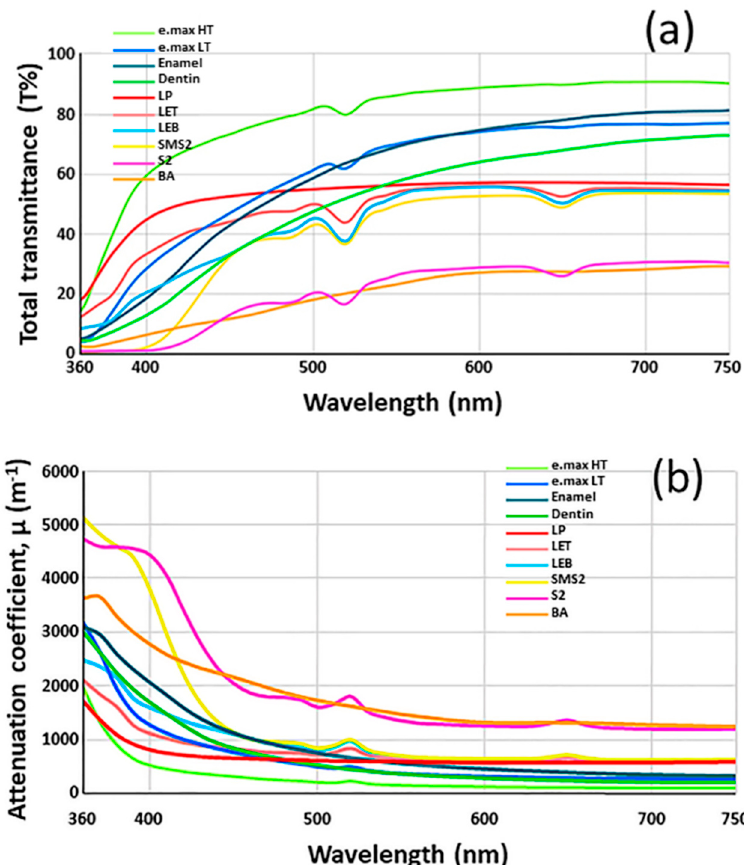
Figure 2. ( a ) Spectral light transmittance (T%) of each group as a function of wavelength. The e.max HT exhibited the highest transmittance value. ( b ) Attenuation coefficients ( μ ) as a function of wavelength. The attenuation coefficients decreased as the wavelength increased.